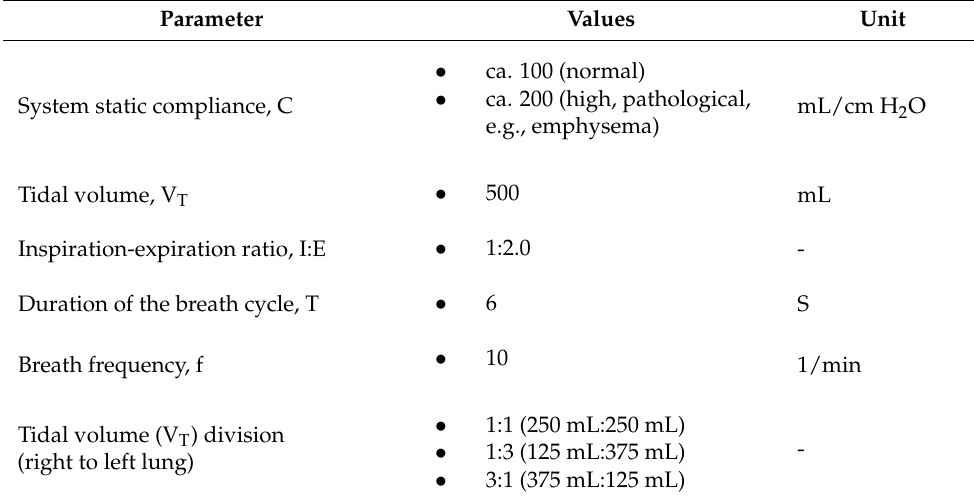
Table 2. Experimental variants.